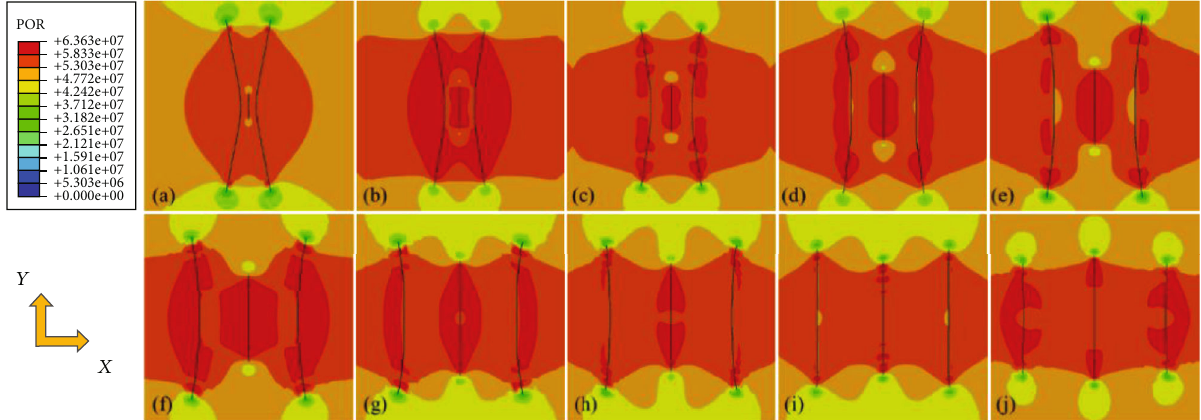
Figure 8: Fracture propagation at di ff erent cluster spacings: the cluster spacing of (a ~ j) is 5 ~ 50 m in order.